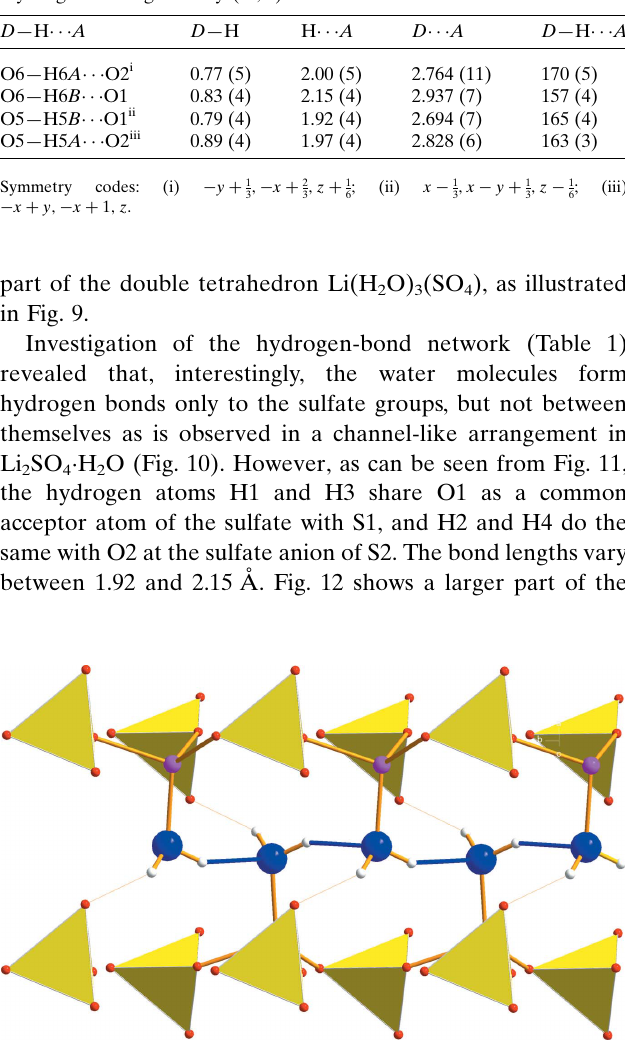
Figure 10 Hydrogen-bonded (blue bonds) chain of water molecules along the b- axis direction in the structure of Li 2 SO 4 (cid:2) H 2 O (Fugel et al. , 2019)